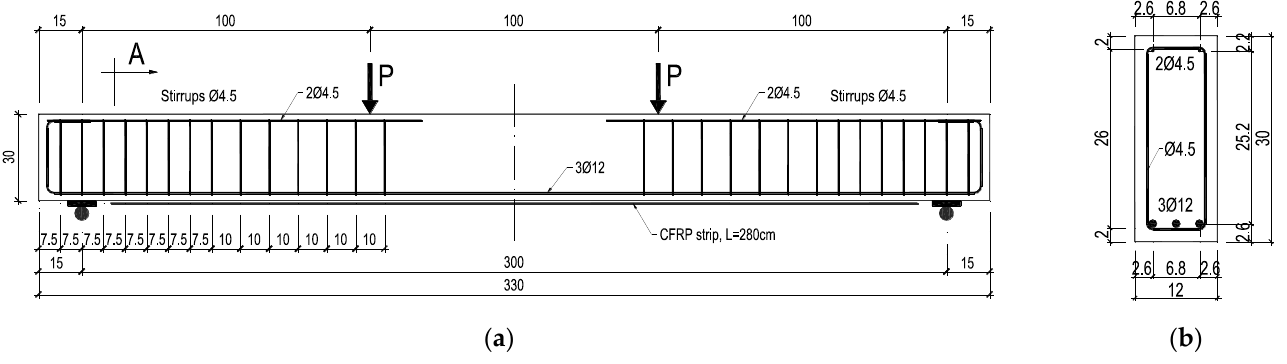
Figure 1. Construction drawing of tested beams: ( a ) side view and ( b ) cross-section [2,3]. The side view and cross-section of all tested beams together with the layout of reinforc- ing bars are shown in Figure 1. On the bottom surfaces of all strengthened beams, CFRP strips were applied due to flexure (S&P Lamelle CFK type 150/2000). Each composite strip had a length of 2.80 m and cross-section of 0.05 m × 1.2 mm and was bonded to concrete surfaces by means of a two-component epoxy resin adhesive [3]. A detailed description of the test stand, used materials, test procedure, and main results were presented in [3,4]. At the beginning, comprehensive measurements of all used materials have been conducted. The mean measured yield strength and modulus of elasticity of the 12 mm reinforcing bars were 550.80 MPa and 210.50 GPa, respectively. The 4.5 mm reinforcing bars, without explicit yield plateau, had a 0.2% yield proof stress of 554.70 MPa and a modulus of elasticity of 193.30 GPa. Poisson’s ratio for both bar types was assumed as 0.3. The modulus of elasticity and Poisson’s ratio of the CFRP strips were measured as 158.95 GPa and 0.2,